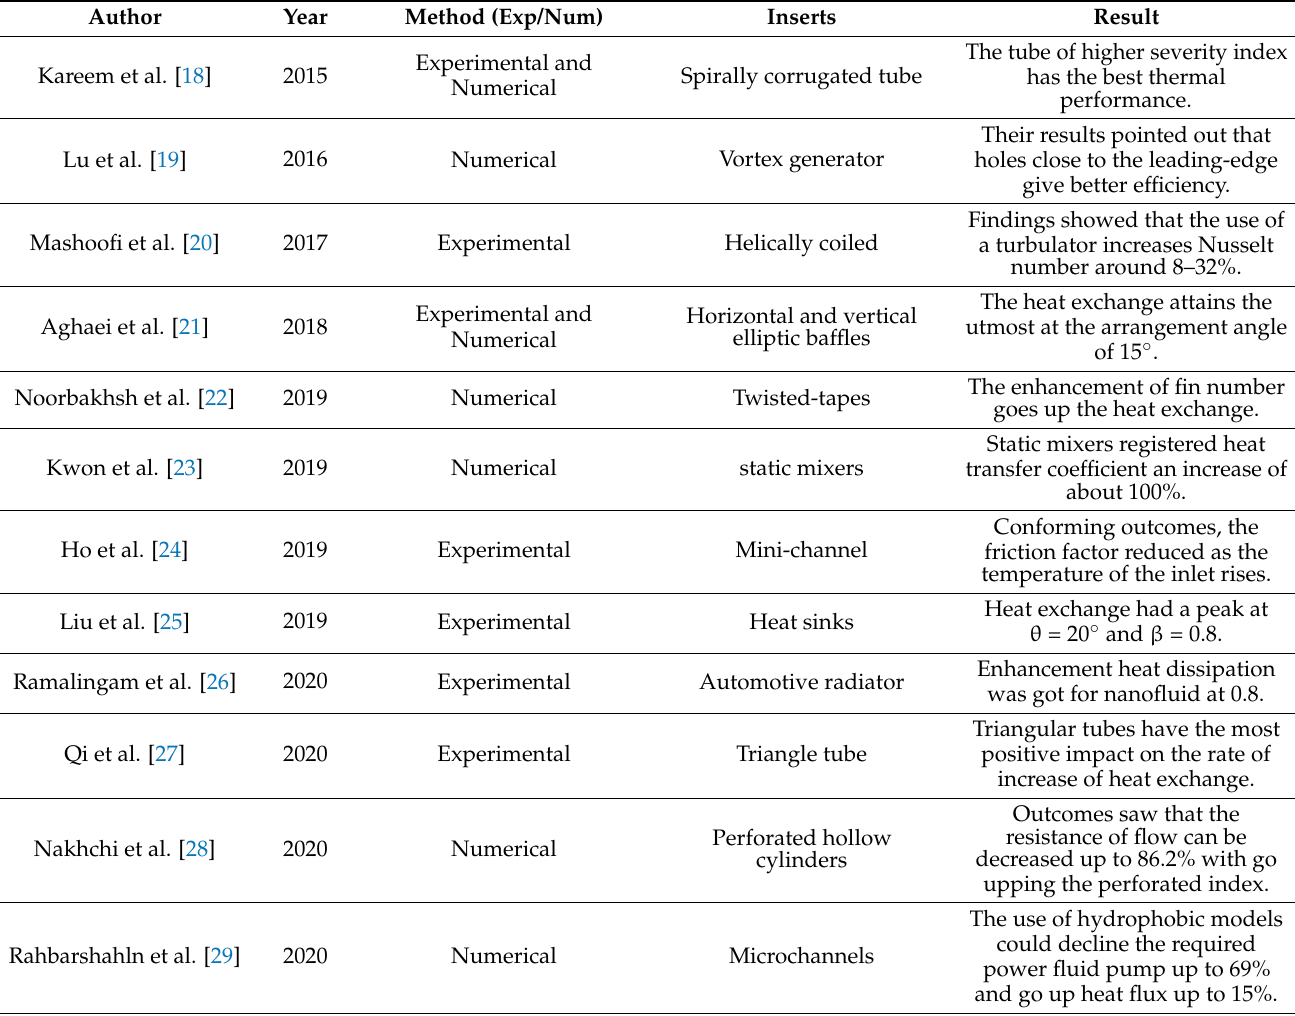
Table 1. Overview of articles to improve the heat